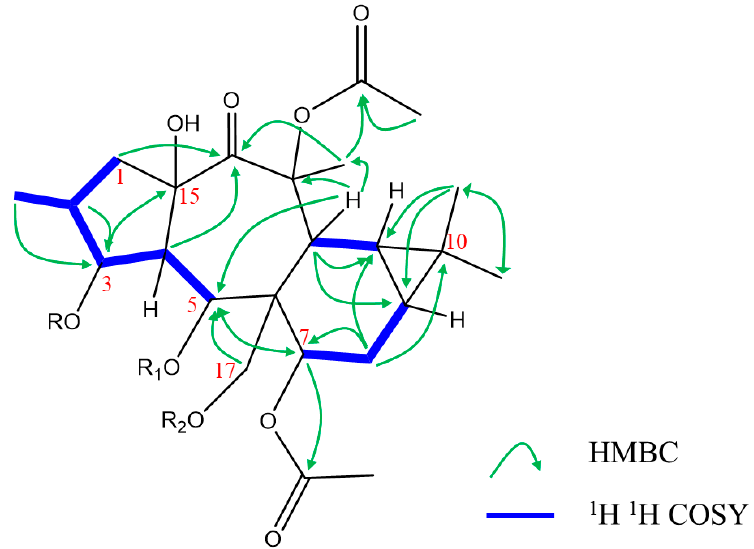
Figure 2. Selected significant 1 H 1 H COSY, and Key HMBC correlations of 1 – 3 .